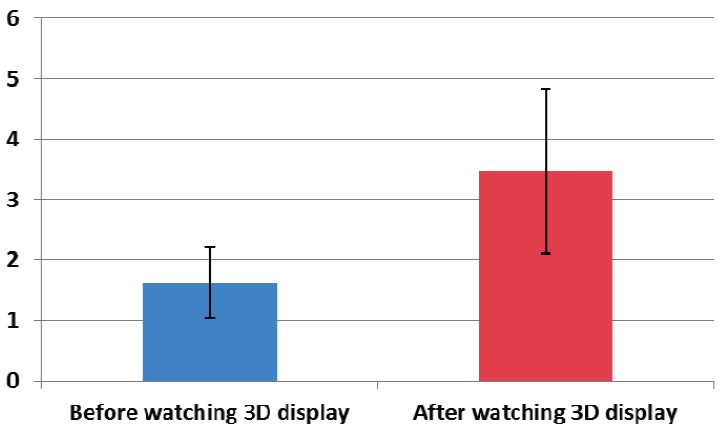
Figure 9. Comparison of SE scores before and after watching the 3D display.